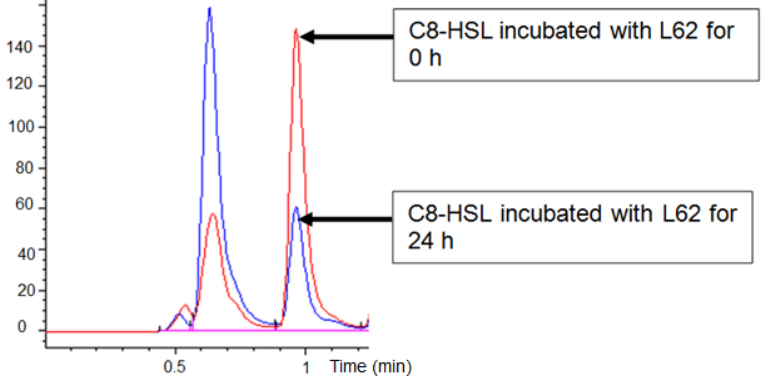
Figure 4. RRLC analysis of C8-HSL after incubation with B. sonorensis L62 resting cells for 0 (red) and 24 h (blue). Note the degradation of C8-HSL after incubation for 24 h corresponded to the drop of peak (with retention time (RT) at 0.95 min in the RRLC chromatogram). Preceding peak (RT = 0.65 min) was solvent front. mAU: Absorbance unit at 210